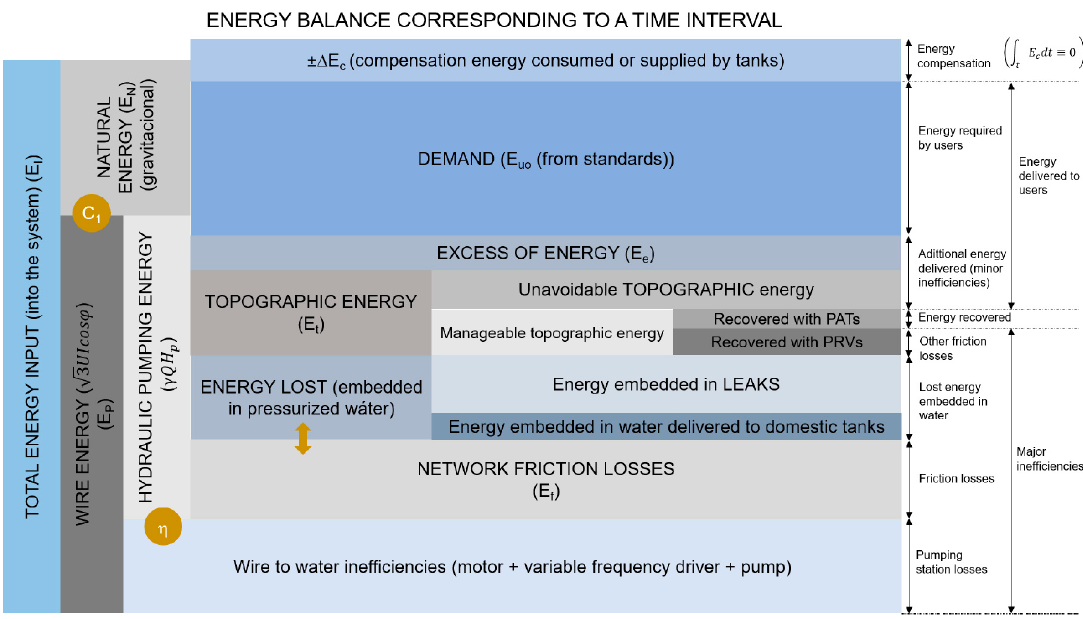
Figure 1. Global energy balance of a network.